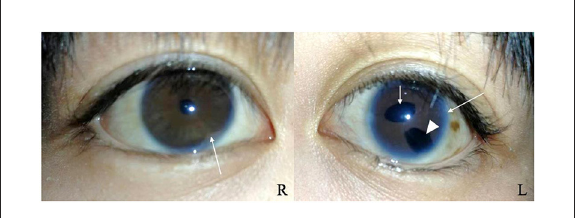
FIGURE1 Slit-lamp photographs of the right and left eyes. Both eyes show anterior synechia (long arrows). The left eye shows pupil deformation and deviation (short arrow), iris atrophy causing the formation of a localized pore (arrowhead).